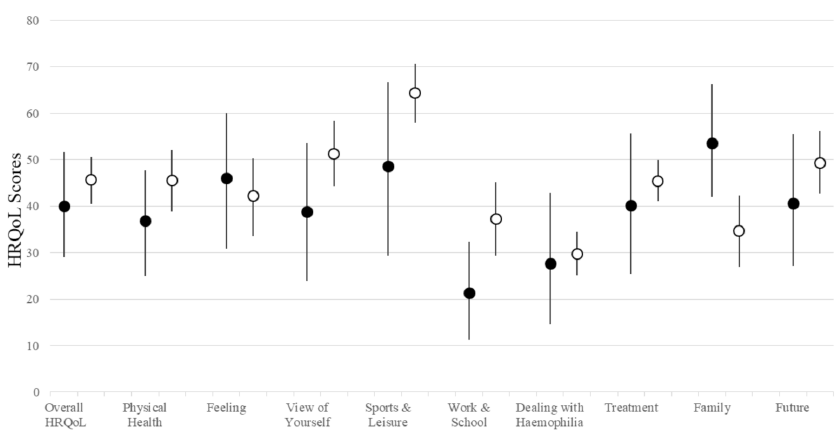
Figure 1. Health-related Quality of Life in Pediatric and Adult Patients with Hemophilia. HRQoL: health-related quality of life. A higher score is indicative of worse health-related quality of life (range: 0 to 100). Error bars represent 95% CI. Black: HRQoL scores of pediatric patients ( n = 14). White: HRQoL scores of adult patients ( n = 42). Descriptive statistics of the HRQoL scores are presented in Supplement Table